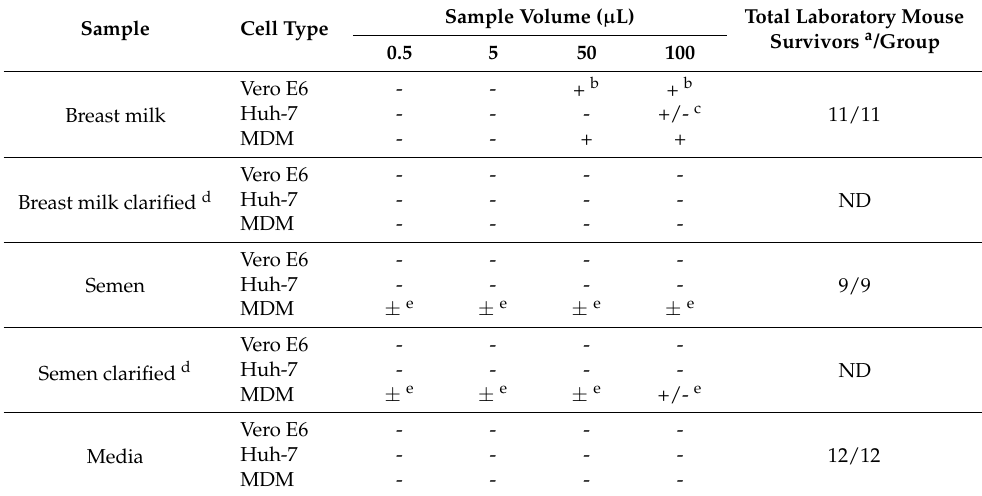
(Table 3). Two animals exposed to semen did not recover from anesthesia and were not counted against the number of survivors. Table 3. Presence or absence (“+” or “-“) of semen- or breast milk-associated matrix toxicity at varying concentrations in vitro and survival in vivo at day 10 post-exposure.